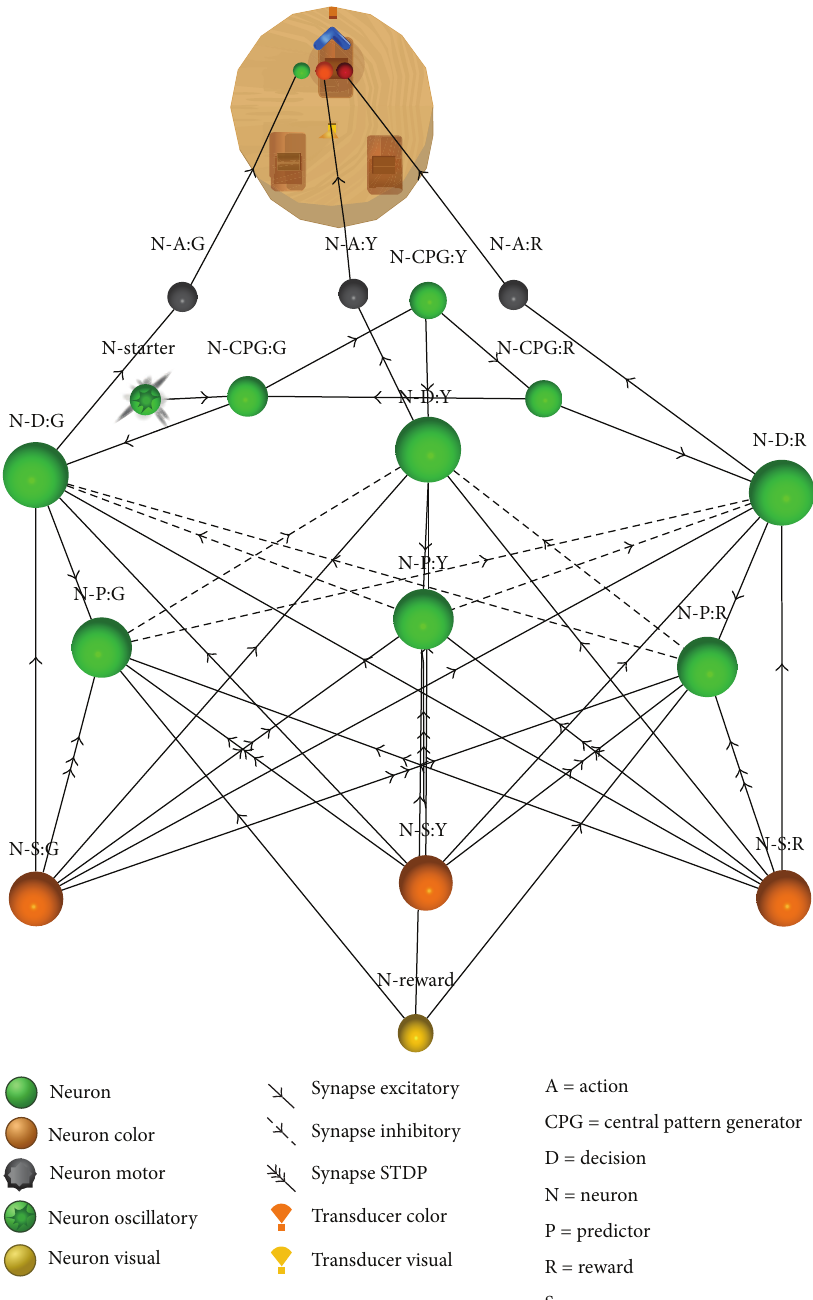
Figure 4: SNN architecture used for our experiments, demonstrating the interrelation of the AS process and the OC learning rule in a three- sensor and three-motor configuration. See also Figure 3: A = action, CPG = central pattern generator, D = decision, G = green, N = neuron, P = predictor, S = synapse, R = red, Y = yellow, and STDP = three consecutive arrows on a synapse.